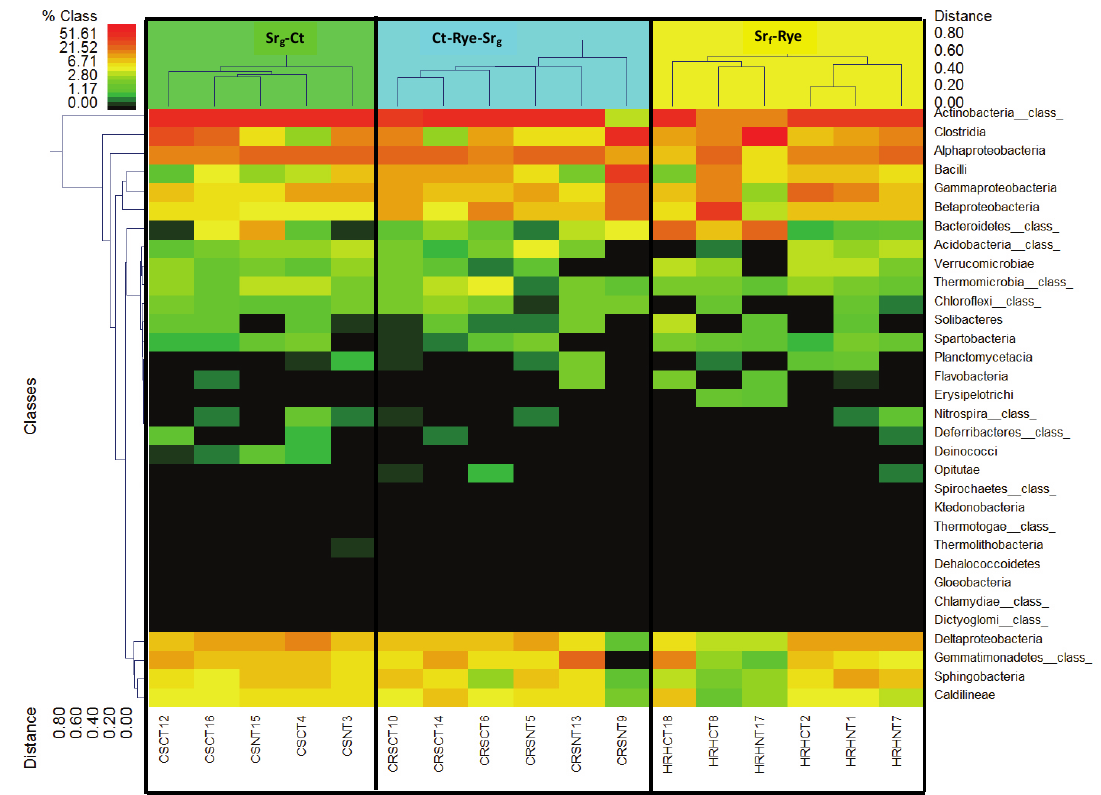
Figure 2. Double hierarchal dendogram to evaluate bacterial distribution in this soil (heat map) using the weighted-pair group clustering method and Manhattan distance method with no scaling. The heat map colors represent the relative percentage of the bacterial classes within each treatment with the legend indicated at the upper left of the figure. The treatments along the X-axis with Manhattan distances are indicated by branch length and an associated scale located at the upper right of the figure. Clustering based upon Manhattan distance of the bacterial classes along the Y-axis and their associated scale is indicated in the lower left. Sr g